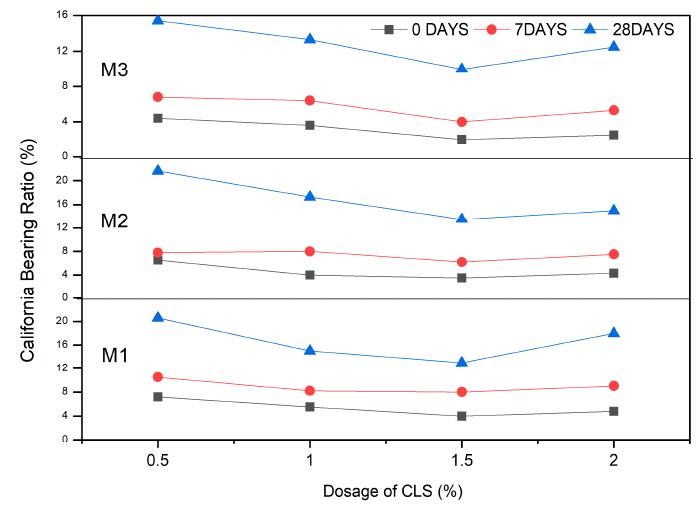
Figure 8. Variation in CBR of soil in presence of GS and